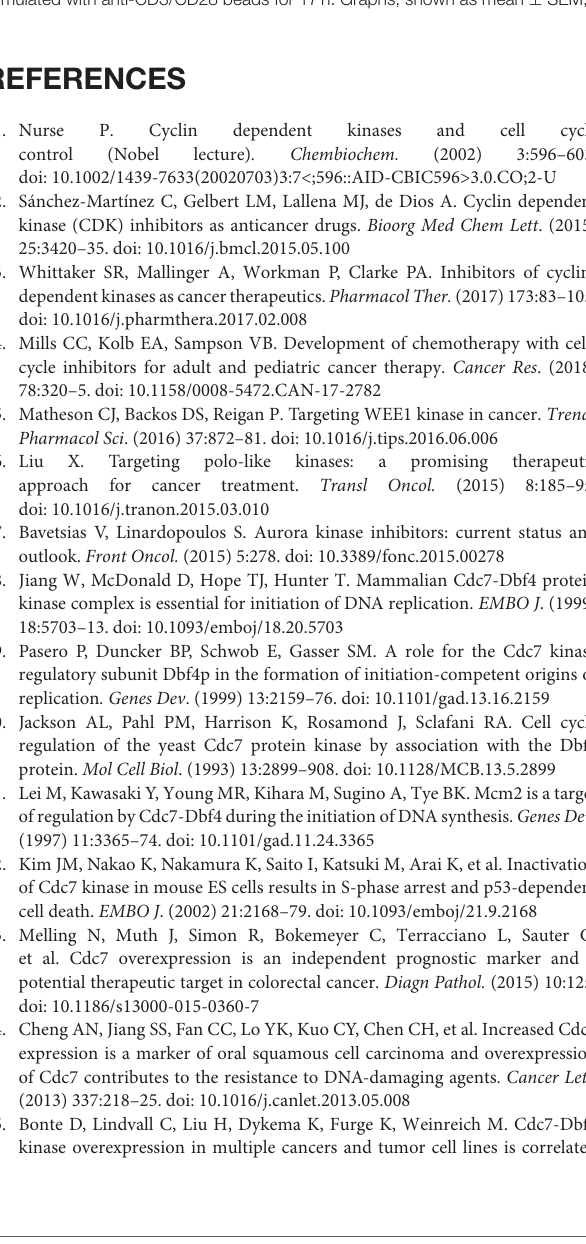
Figure S5 | Cdc7 inhibitors suppress T cell activation. (A) Effect of inhibitors of various cell cycle components on the activation of thymocytes. Thymocytes were stimulated with anti-CD3/CD28 beads for 17h. Graphs, shown as mean ± SEM,